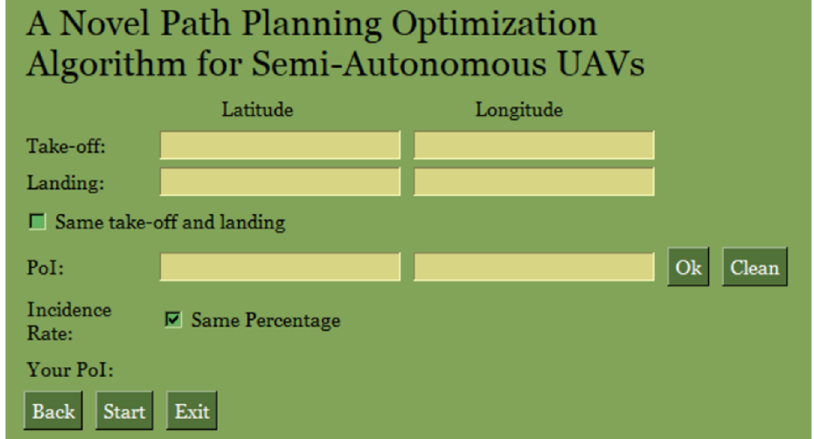
Figure 5. Second window of the path planning optimization algorithm GUI.